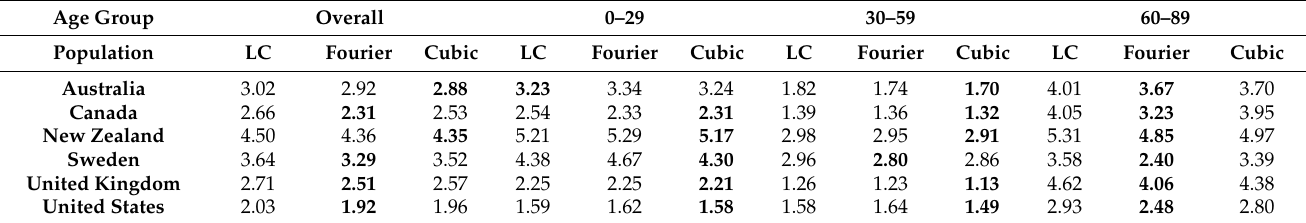
Table 1. MAPE values (%) of projected log central death rates of all ages and 30-year age groups (rolling-window basis). The minimum MAPE values for each age group and each country are given in